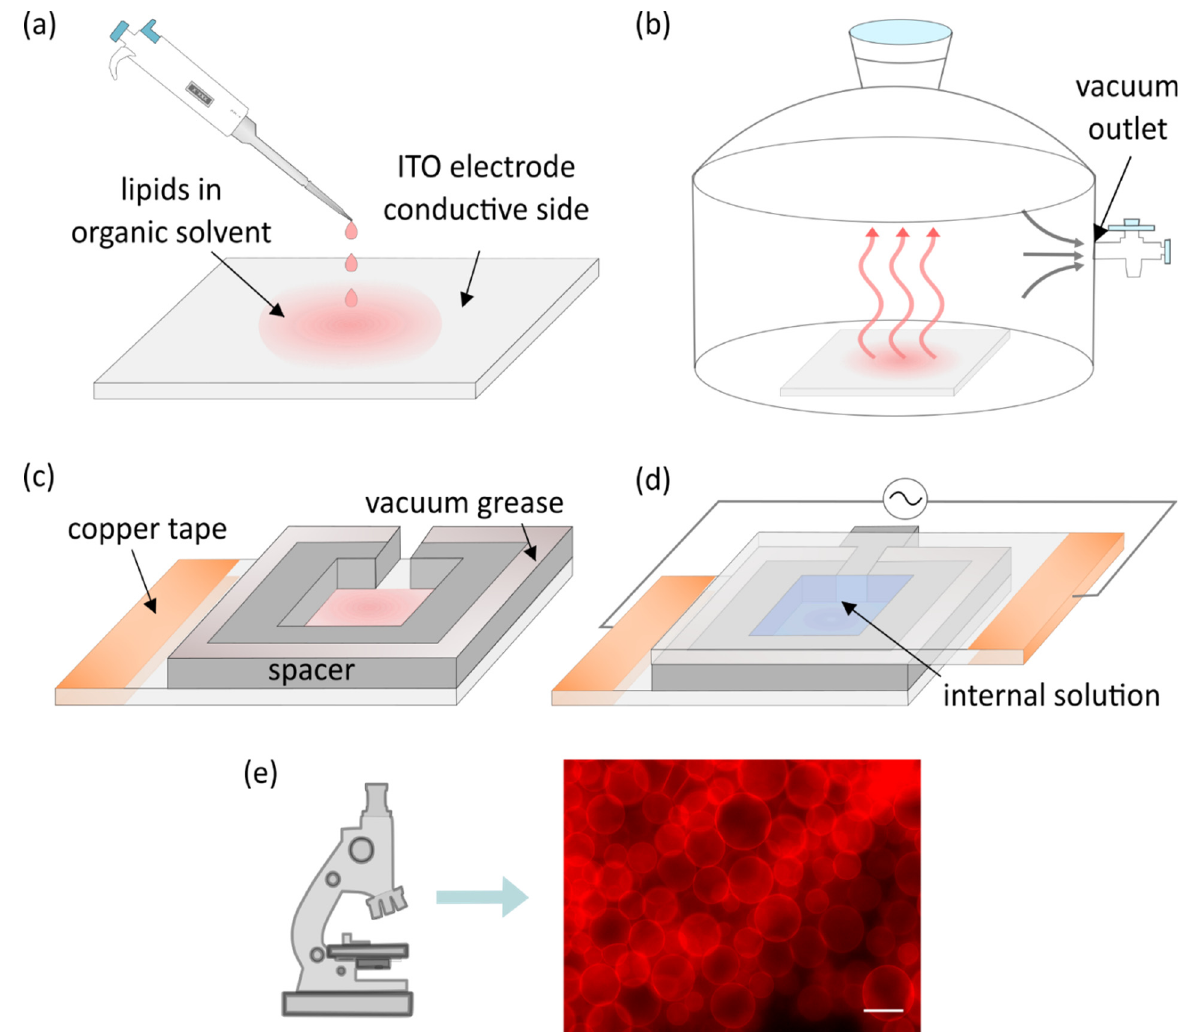
Figure 1. ( a ) Deposition of lipid droplets onto the electrode surface. ( b ) Evaporation of organic solvent under vacuum. ( c ) Construction of the electroformation chamber. ( d ) Electroformation chamber filled with an internal solution and connected to an alternating current function generator. ( e ) An image of fluorescently labeled giant unilamellar vesicles (GUVs) obtained using fluorescence microscopy. The scale bar denotes 50 µm.